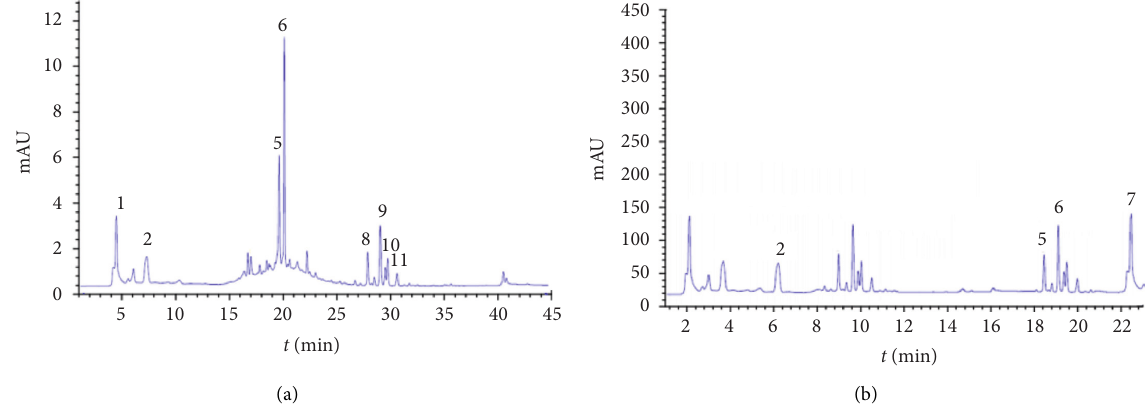
Figure 1: HPLC-DAD profile (280 nm (a) and 320 (b)nm) of the apricot pomace extract.